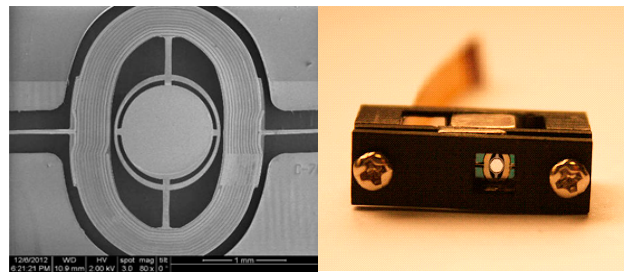
Figure 7. The image of the fabricated micromirror and package die assembly of the micromirror.